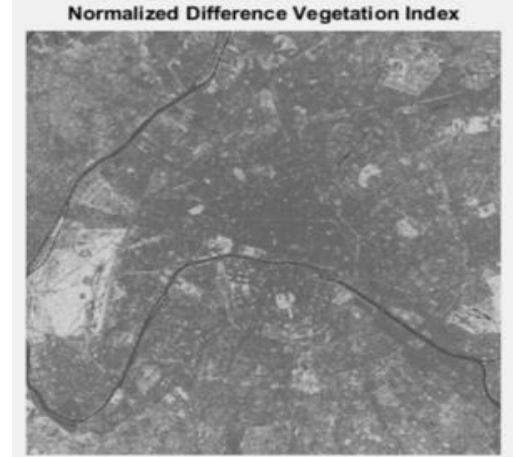
Figure 12. NDVI image of the analyzed land.